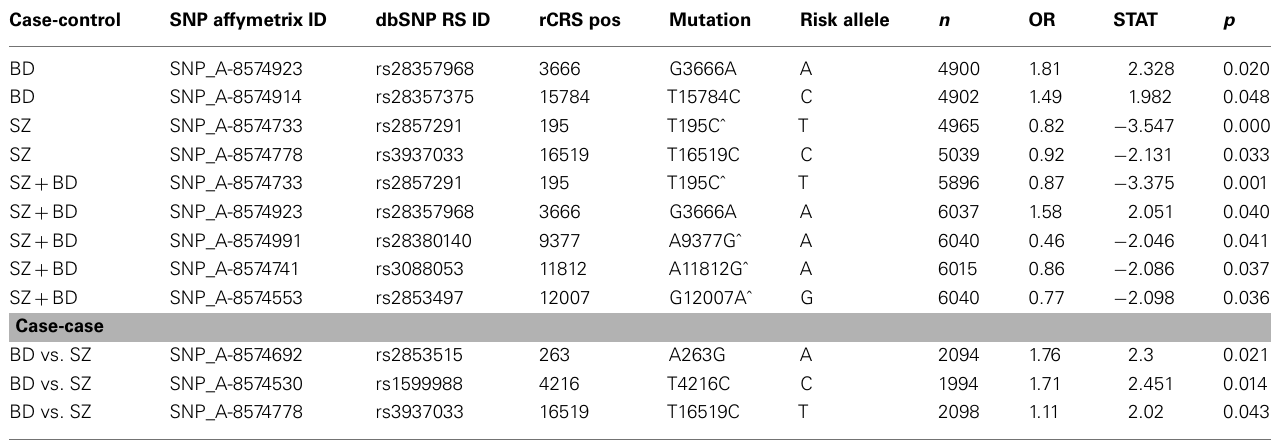
Table 3 | mtDNA SNPs fromAffymetrix cel files were used to calculate association with MDS covariates.